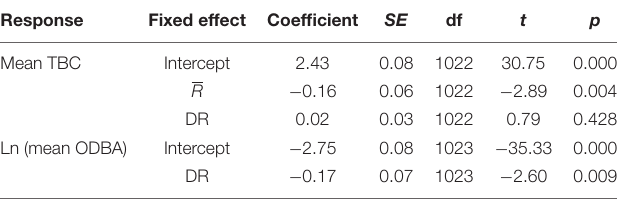
TABLE 4 | Coefficients and significance for parameters from linear mixed models evaluating relationships between mean resultant length ( R ), diving ratio (DR), mean tailbeat cycle (TBC), and mean overall dynamic body acceleration (ODBA).